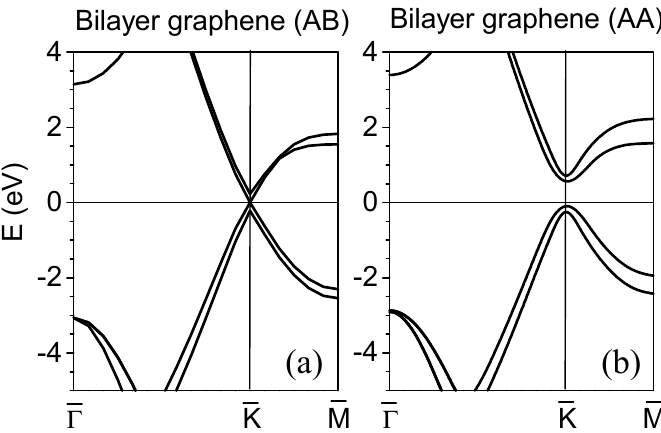
Figure 2. Band structures for free graphene bilayers with the AB layer configuration, pertinent to a bulk graphite ( a ); and the AA configuration, in which carbon atoms of the second layer are positioned atop the atoms of the first layer ( b ).